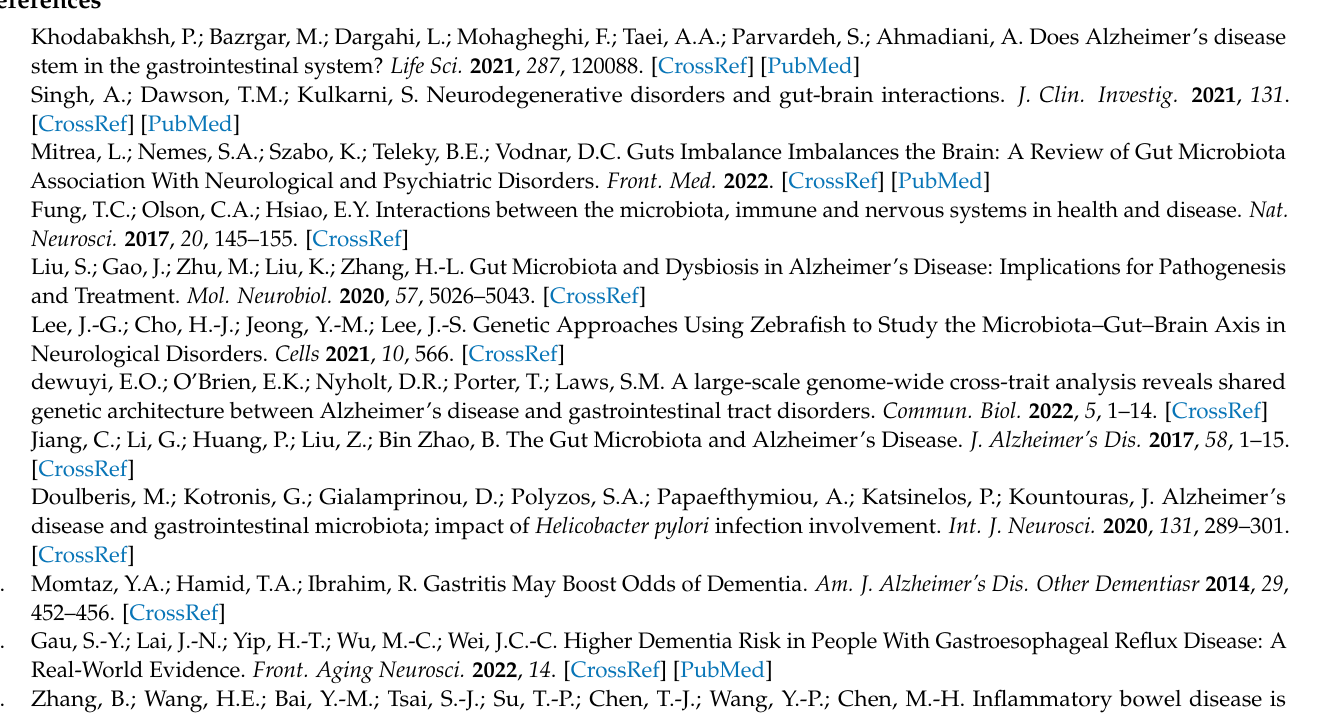
Table S19: Effect sizes of GERD SNPs utilised as instrumental variables on educational attainment in the sensitivity analysis; Table S20: Results of bidirectional Mendelian randomisation analysis between cognitive traits and